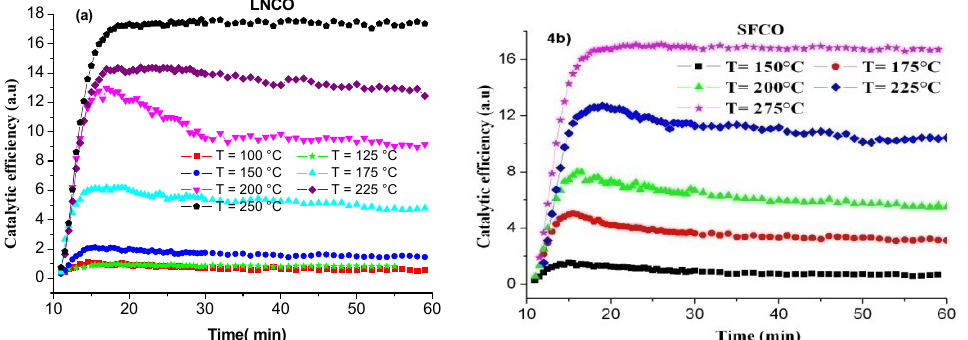
Figure 4. Catalytic activity reported as a function of time at different